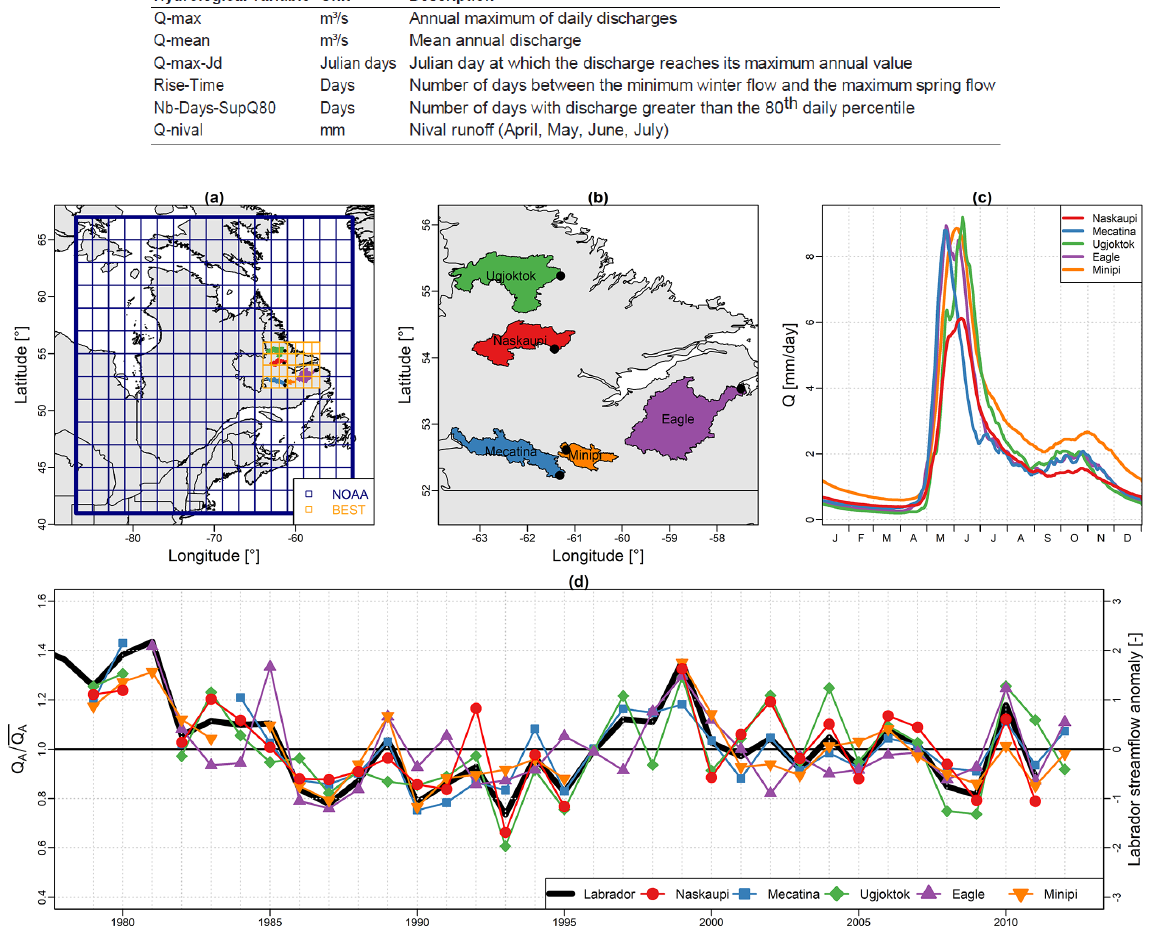
Figure 3. (a) Dataset used for the hydro-climatic reconstruction based on rainfall–runoff modelling: the extension of the 20CR grid used is shown in blue, and the BEST grid used is highlighted in orange. (b) Spatial distribution of hydrometric stations used in this study (black dots) and their catchment areas. (c) Observed mean daily discharges of each hydrometric station for the 1978–2012 period. (d) Labrador streamflow anomaly and the Labrador region mean annual discharge series (thick black